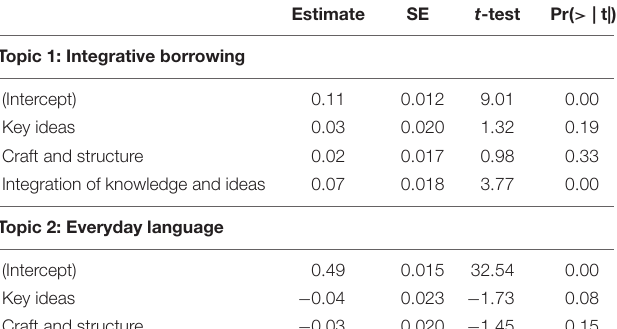
the Figure 3 : (1) students who used more Integrative Borrowing in their answers tended to have higher scores and (2) students who used more Everyday Language in their answers tended to have lower scores.